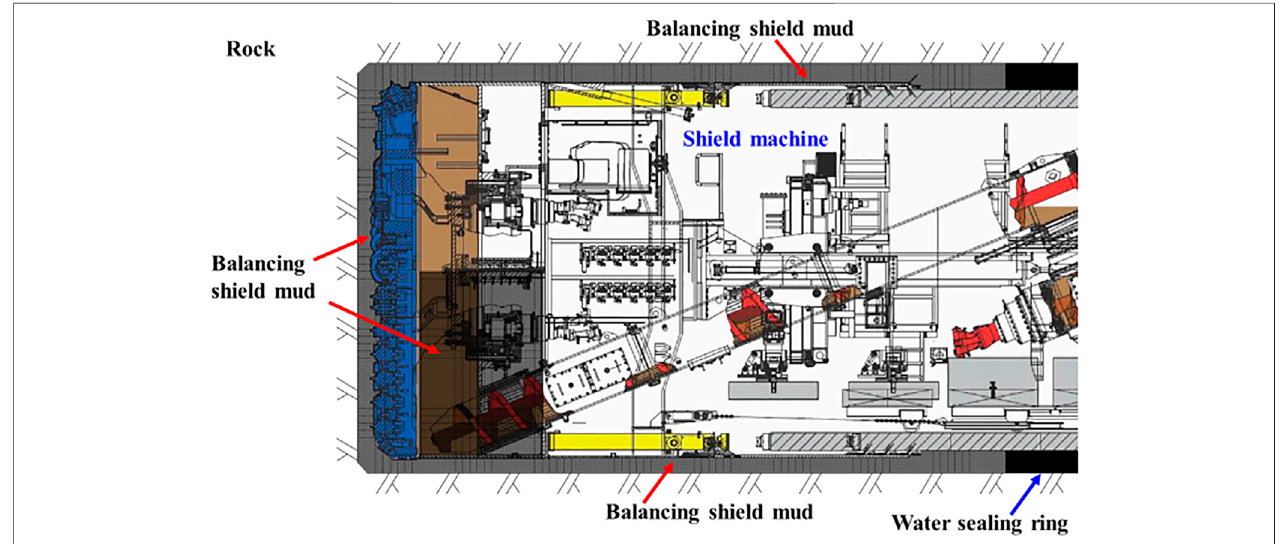
FIGURE 12 | Application diagram of balancing shield